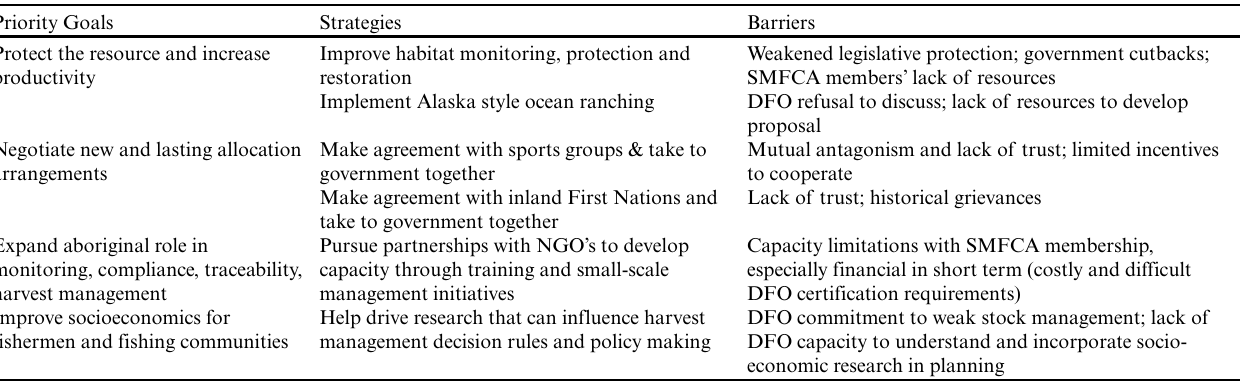
Table 4 . Sustainable Marine Fisheries and Communities Alliance (SMFCA) priority goals, strategies, and barriers (Thorkelson 2012, City of Prince Rupert 2013; SMFCA 2010, personal communication, unpublished documents ). DFO = Canadian Department of Fisheries and